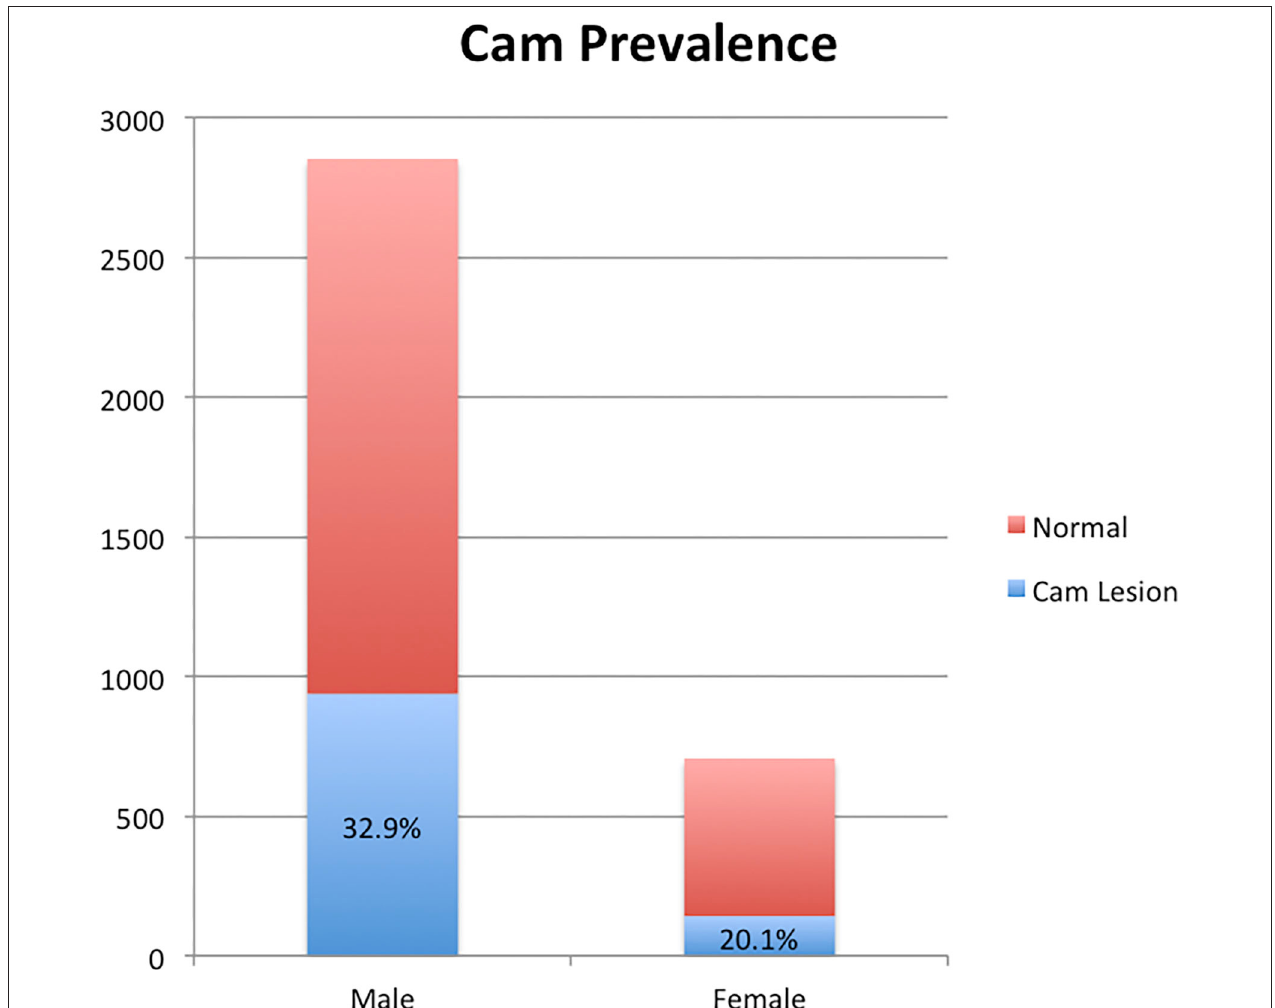
FIGURE 4 | The prevalence of cam deformity witnessed in male and female specimens in the evaluated